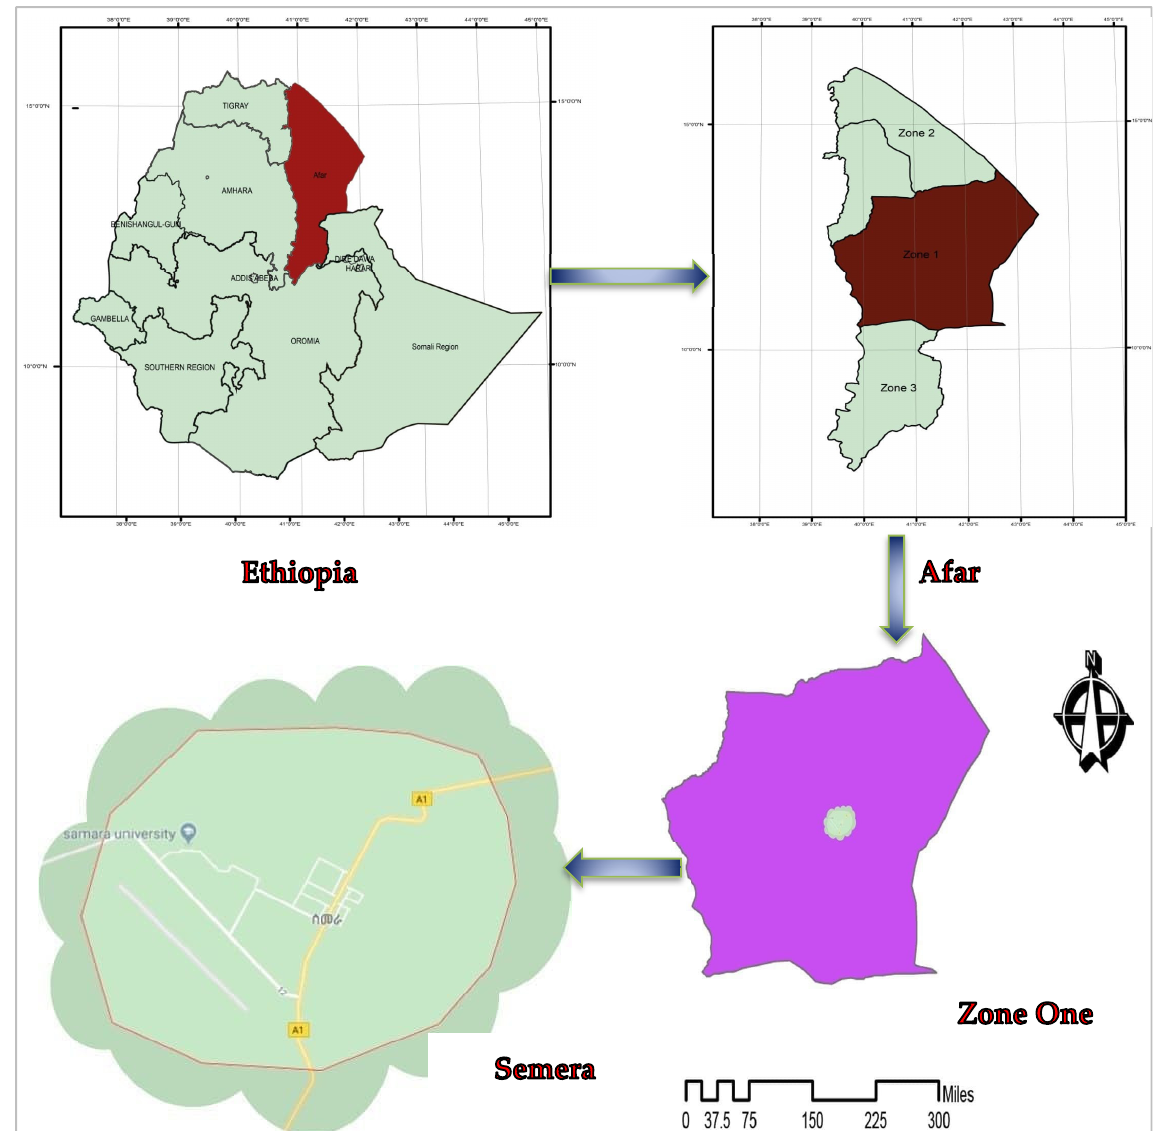
Figure 2. Map of the study area.